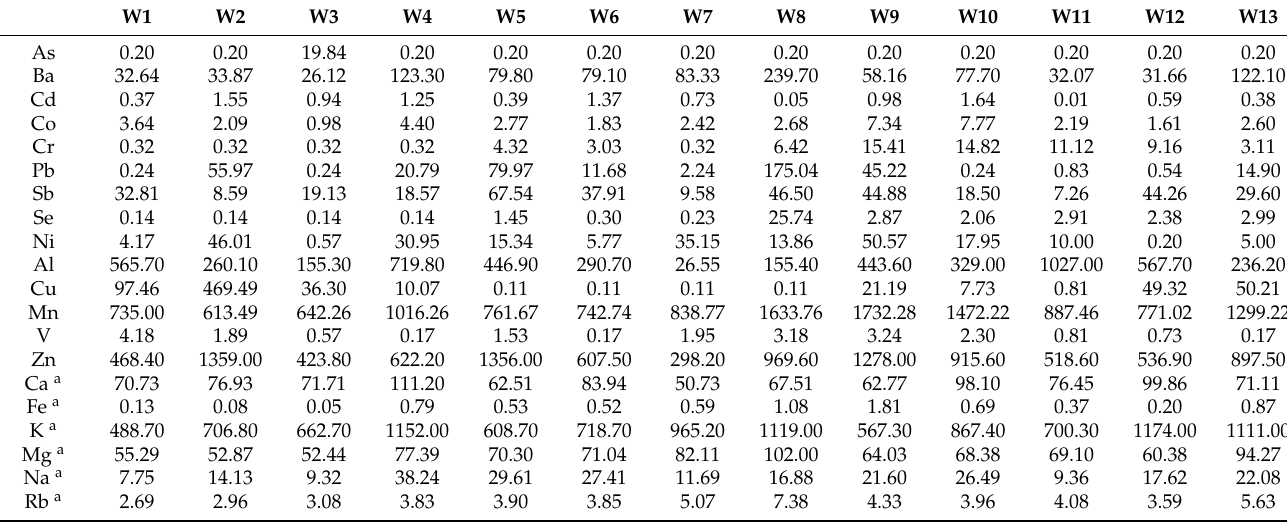
Table 2. Elements quantification in the analyzed Italian wines; the concentrations are reported as µ g/L and were determined by ICP-MS with the exception of the elements indicated as a where the concentrations are reported as mg/L and the analyses were carried out by